Question: In a single sentence, describe what this figure presents.
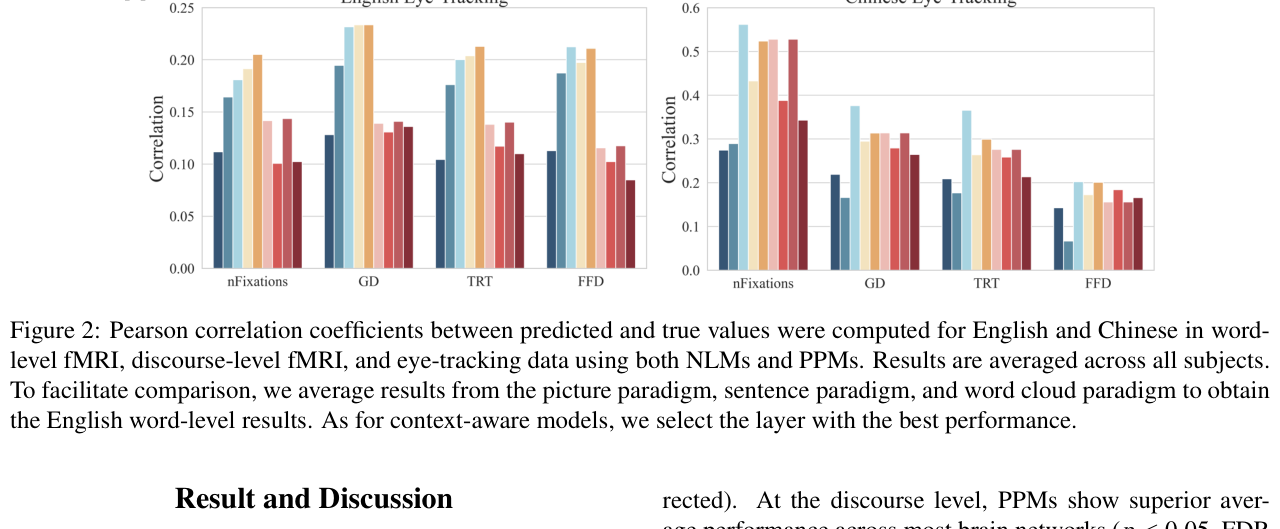
Answer: Pearson correlation coefficients between predicted and true values were computed for English and Chinese in word- level fMRI, discourse-level fMRI, and eye-tracking data using both NLMs and PPMs. Results are averaged across all subjects. To facilitate comparison, we average results from the picture paradigm, sentence paradigm, and word cloud paradigm to obtain the English word-level results. As for context-aware models, we select the layer with the best performance.